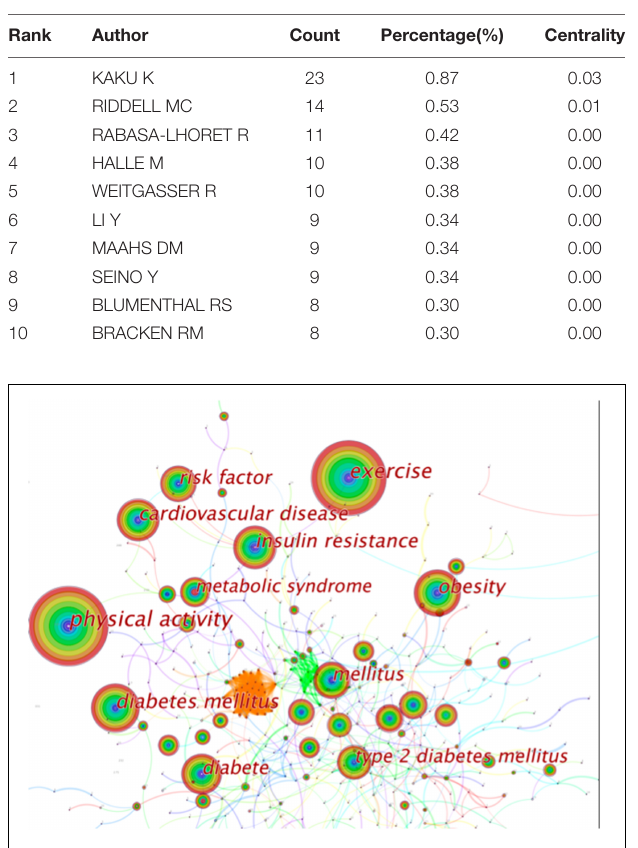
TABLE 5 | The top 10 prolific authors in physical activity therapy for diabetes research.